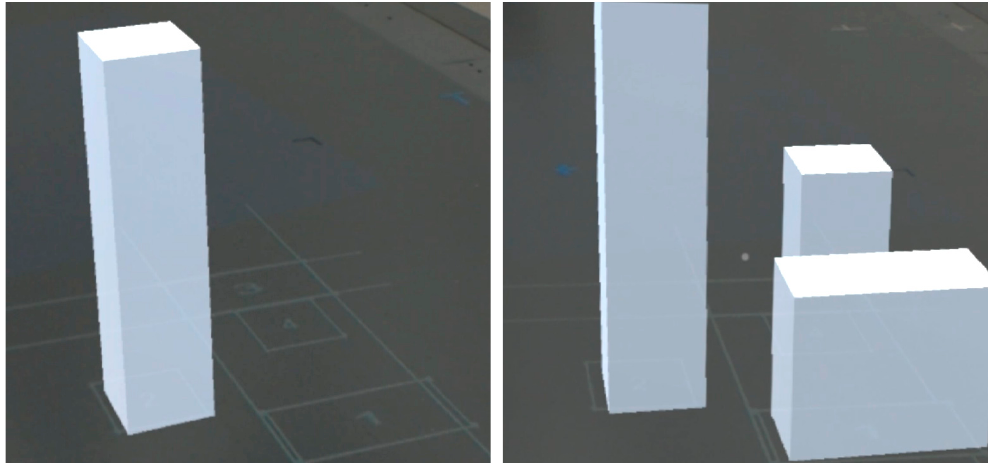
Figure 13. Grid cue highlighting object three whilst squashing all obscuring objects ( left ), and focusing solely on object three, meaning objects one and four remain visible ( right ). Depending on the user’s viewport, different objects will be “squashed” in line with the user’s view. Images have had contrast altered to enhance the visibility of the SAR projections for